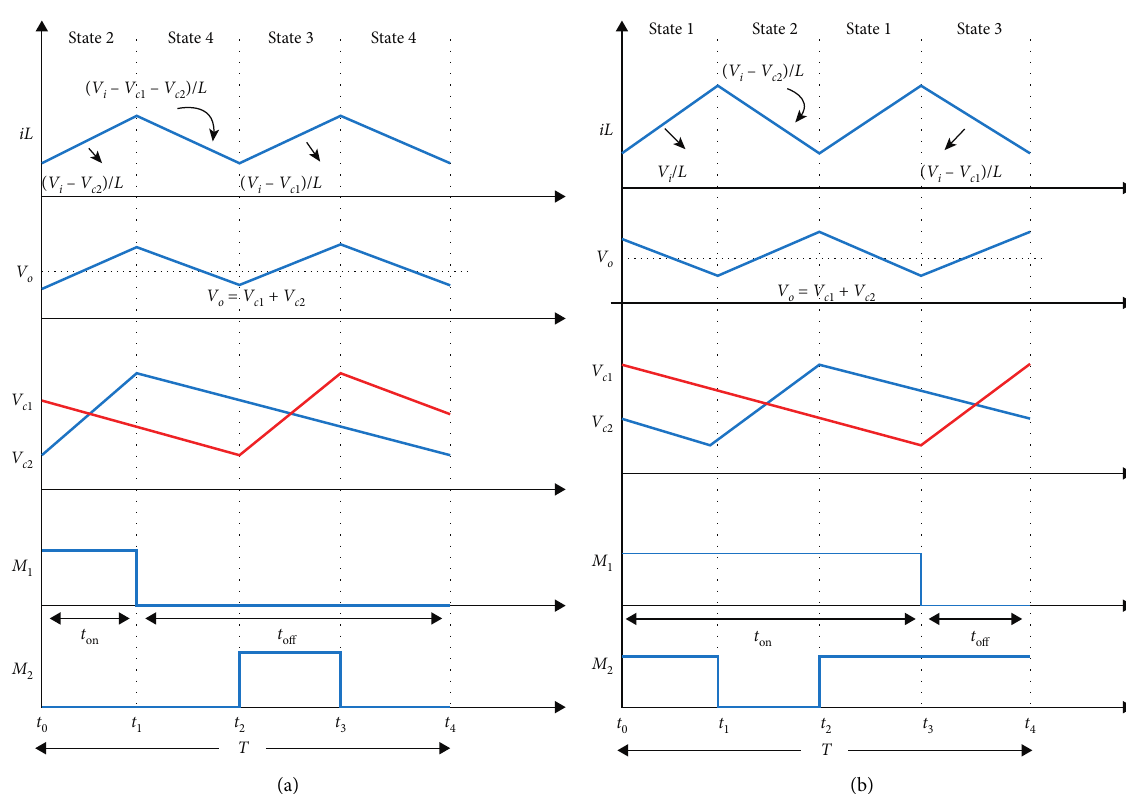
Figure 3: The four operating states of TLBC. (a) M M 1 , M 2 off.